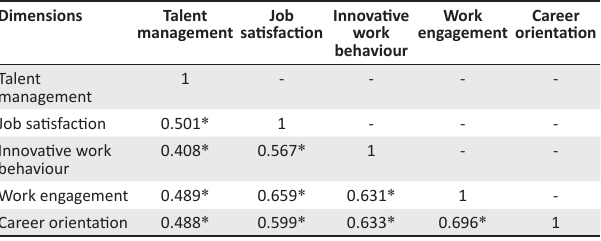
TABLE 3: Correlation between work engagement, talent management, innovative work behaviour, job satisfaction and career orientation . Dimensions Talent management